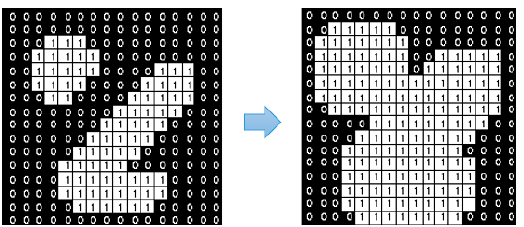
Figure 8. An example of the effect of the dilation operation (https://homepages.inf.ed.ac.uk/rbf/HIPR2/dilate.htm).